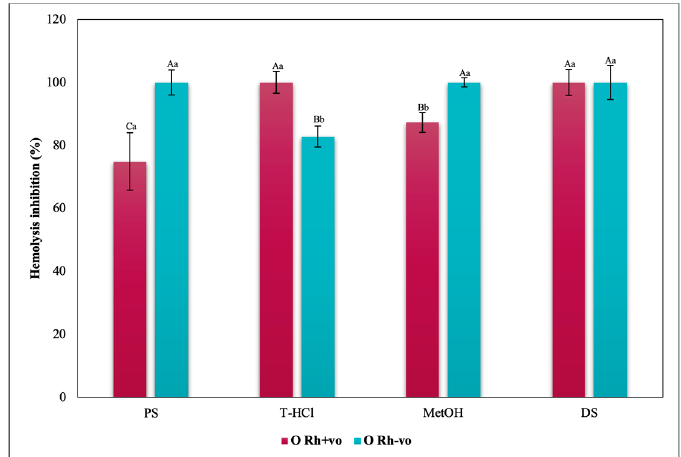
Figure 15. Inhibitory effect of hypotonicity-induced hemolysis of P. cruentum extracts on human erythrocytes with different RhD (positive and negative) of O blood group. Different letters represent significant differences in the means between treatments and groups ( p ≤ 0.001). Capital letters represent a two-way ANOVA. Lowercase letters represent a univariate ANOVA between the extracts. PS, extract of physiological solution; T-HCl, 0.5 M Tris-HCl extract; MetOH, 99% methanol extract; SD, sodium diclofenac.